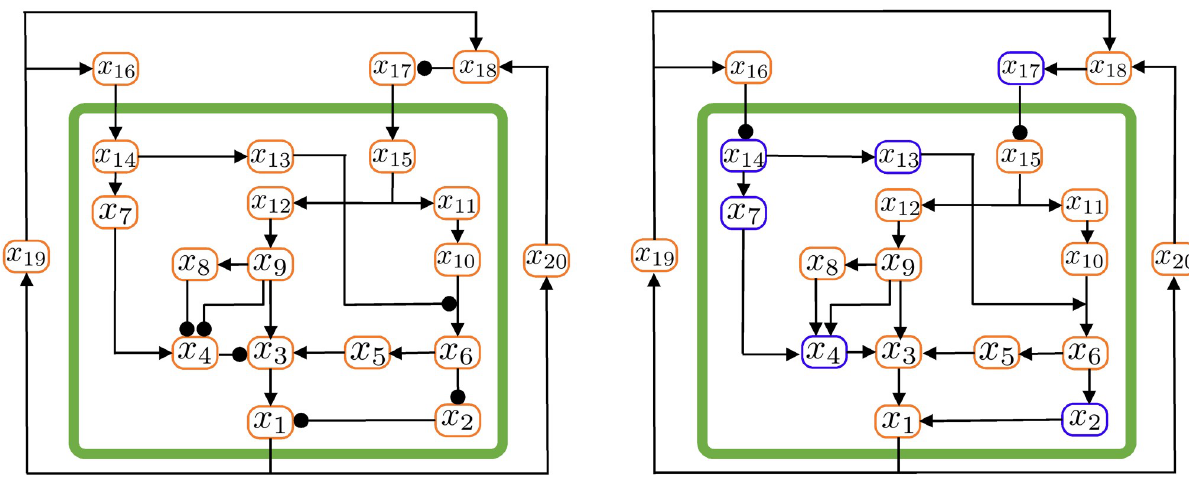
Fig 7. The interaction graph in Fig 3 (left) and its modified version (right). Pointed arrows represent activation arcs, while circle-head arrows represent inhibition arcs.